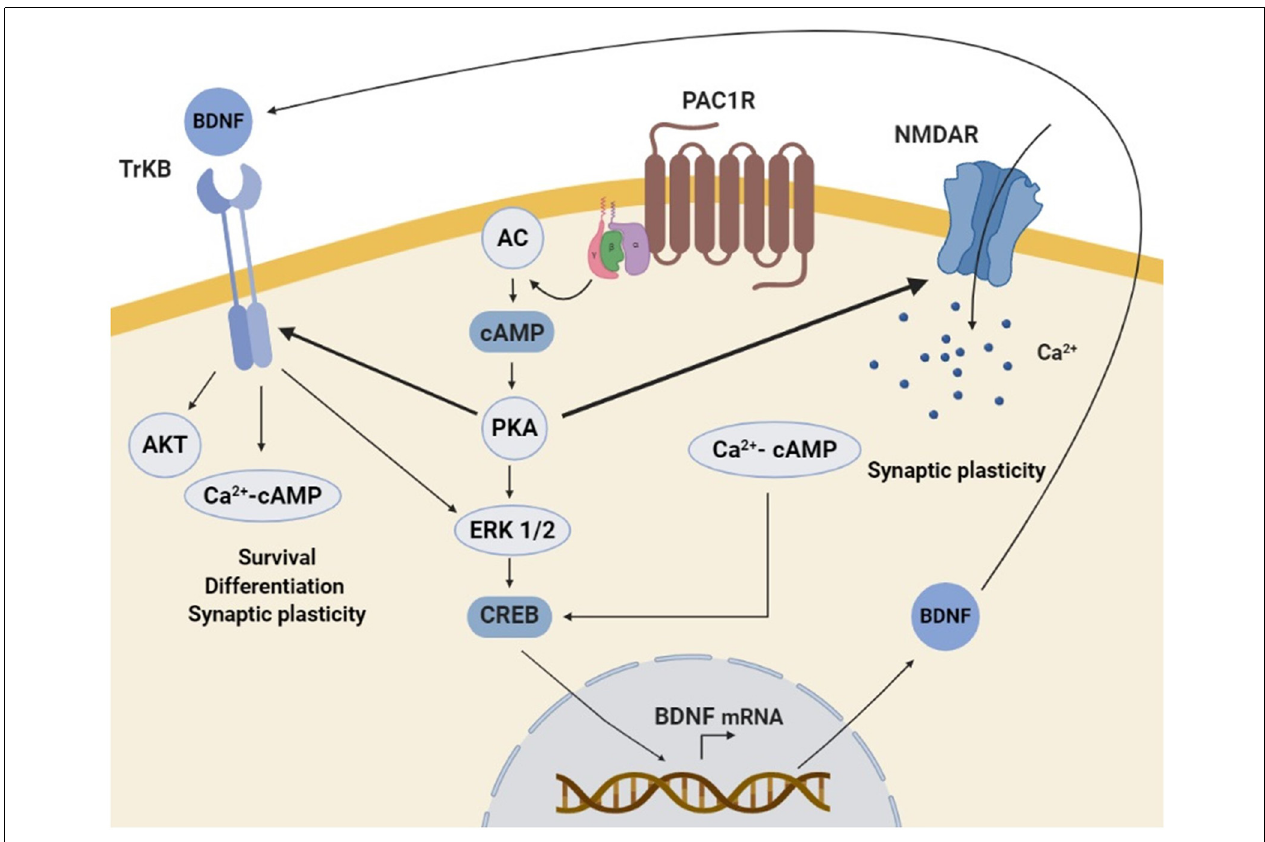
FIGURE 3 | Schematic representation of the molecular mechanisms involved in PAC1R mediated neurotrophic effect. The stimulation of PAC1R by PACAP activates the protein kinase A (PKA) signaling pathway, which can potentiate N-methyl-D-aspartate (NMDA) receptors and/or induce downstream the phosphorylation of extracellular signal-regulated kinase (ERK). In both cases, CAMP response element-binding protein (CREB) is activated and enhances brain-derived neurotrophic factor (BDNF) transcription. Increased BDNF protein levels activate the TrkB receptor, which can also be potentiated by PKA. Finally, TrkB associated trophic signaling pathways promote neuronal survival, differentiation, and synaptic